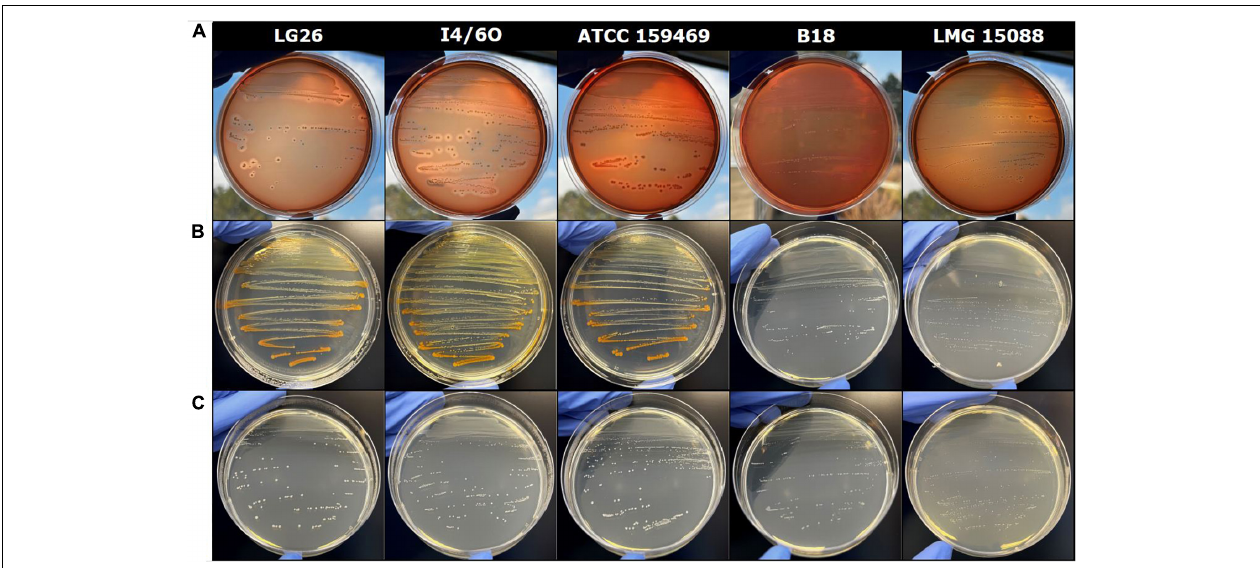
FIGURE 2 | Effect of variable conditions on orange pigment formation. (A-C) Induction of hemolysis on Columbia agar with 5% of sheep blood (A) , orange pigment formation on Wilkins–Chalgren agar (B) , or Wilkins–Chalgren agar at levels with ≥ 3 g L − 1 of D -glucose (C) , all plates were cultivated under anaerobic conditions at 37 ◦ C; L. garvieae/petauri/formosensis (LG26, golden lion tamarin origin; I4/6O, insect origin; 159469 T , oral abscess in a sugar glider; B18, infant origin), S. agalactiae (LMG 15088, unknown